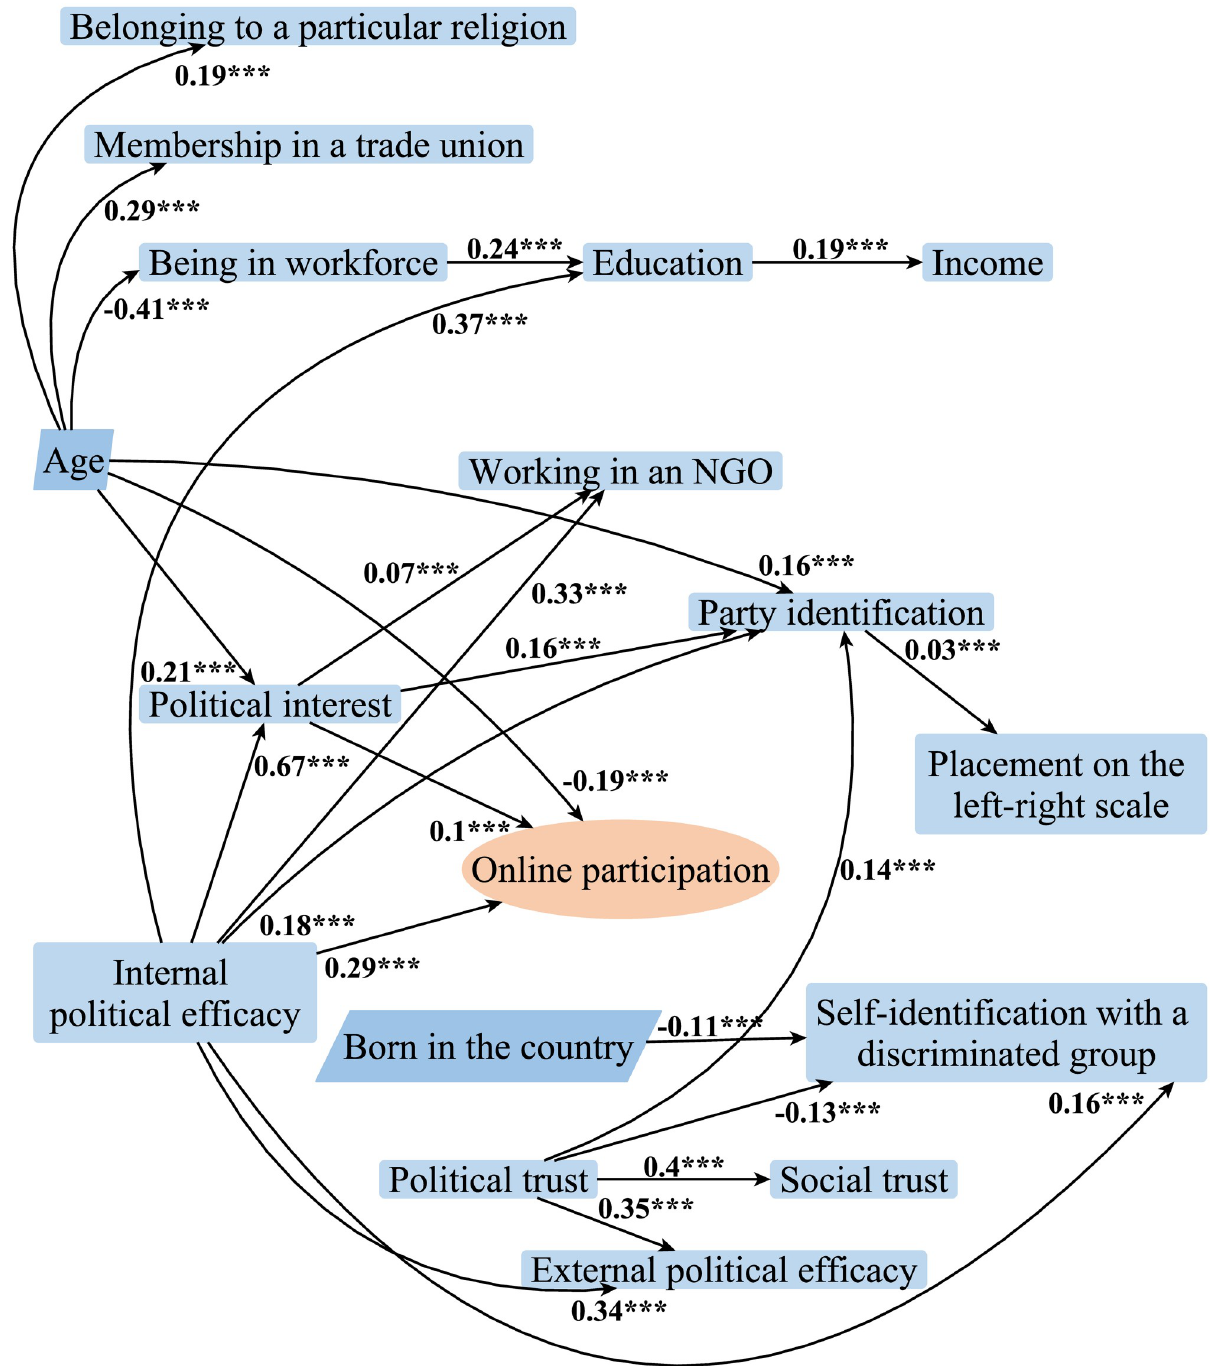
Fig 4. Directed acyclic graph of the relations between factors associated with participation in online activism. Source : ESS 2018 [35]. N = 27 379 individuals in 19 countries. Notes : Structural equation modeling was applied to analyse the data. Entities depicted in association with the edges are parameter estimates of the structural equation modeling. Sign.: � p < 0.05; �� p < 0.01; ��� p < 0.001. All variables are individual level variables.